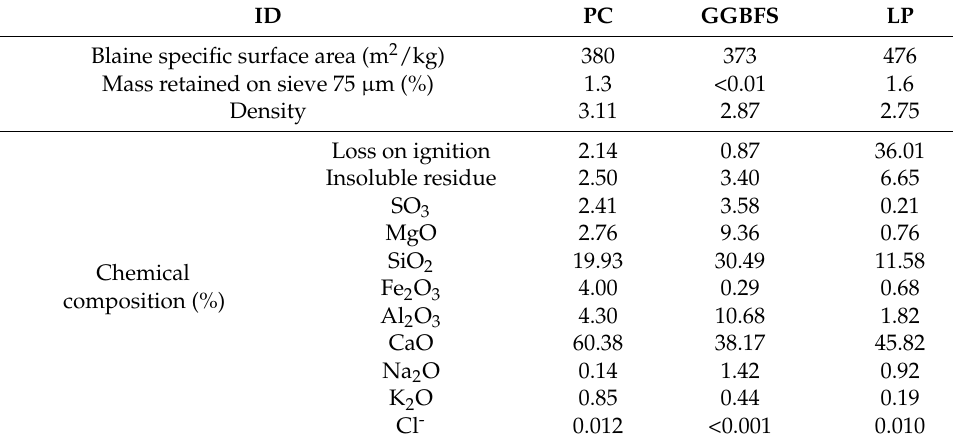
Table 2. Properties of Portland cement and supplementary cementitious